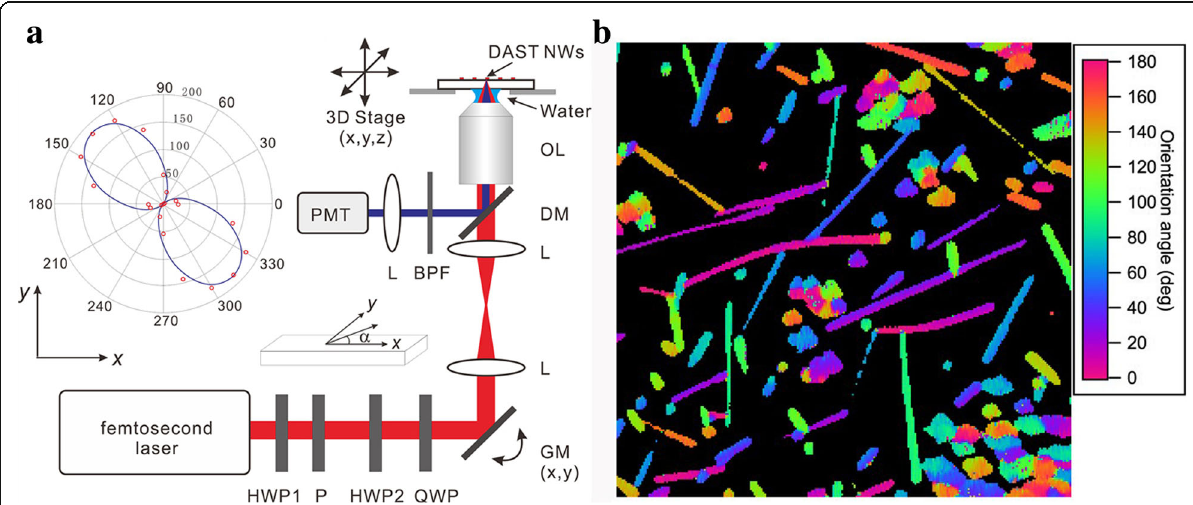
Fig. 4 a The SHG microscopy setup, where L is a lens, OL is an objective lens, DM is a dichroic mirror, GM is a galvanometer mirror, P is a polarizer, HWP is a half-wavelength polarizer, QWP is a quarter-wavelength polarizer, BPF is a band-pass filter, and PMT is a photomultiplier tube. The inset is a typical plot of the SHG intensity of a NW as a function of the incident laser polarization angle, where the red dots indicate the experimental data, and the solid blue lines represent theoretical fits. b SHG image of DAST NWs and their orientation angles, the field size is